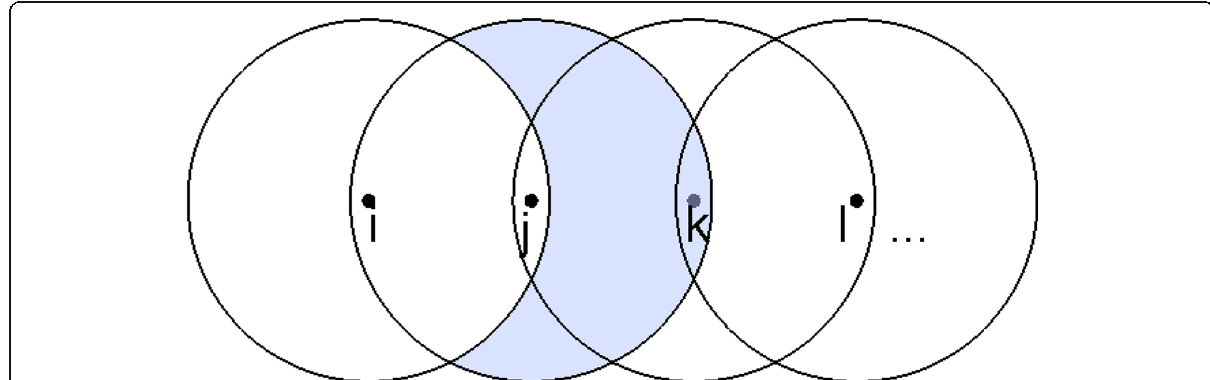
Fig. 4 Correlation chain of retaining probability. Assume m i > m j , node i is retained, if m j is the only mark lower than m i in C i and j is not retained. The reason for j not being retained ( j has the second lowest mark) is that k is retained, if m k is the only mark lower than m j in C j . The solution is transformed to the retaining probability of node